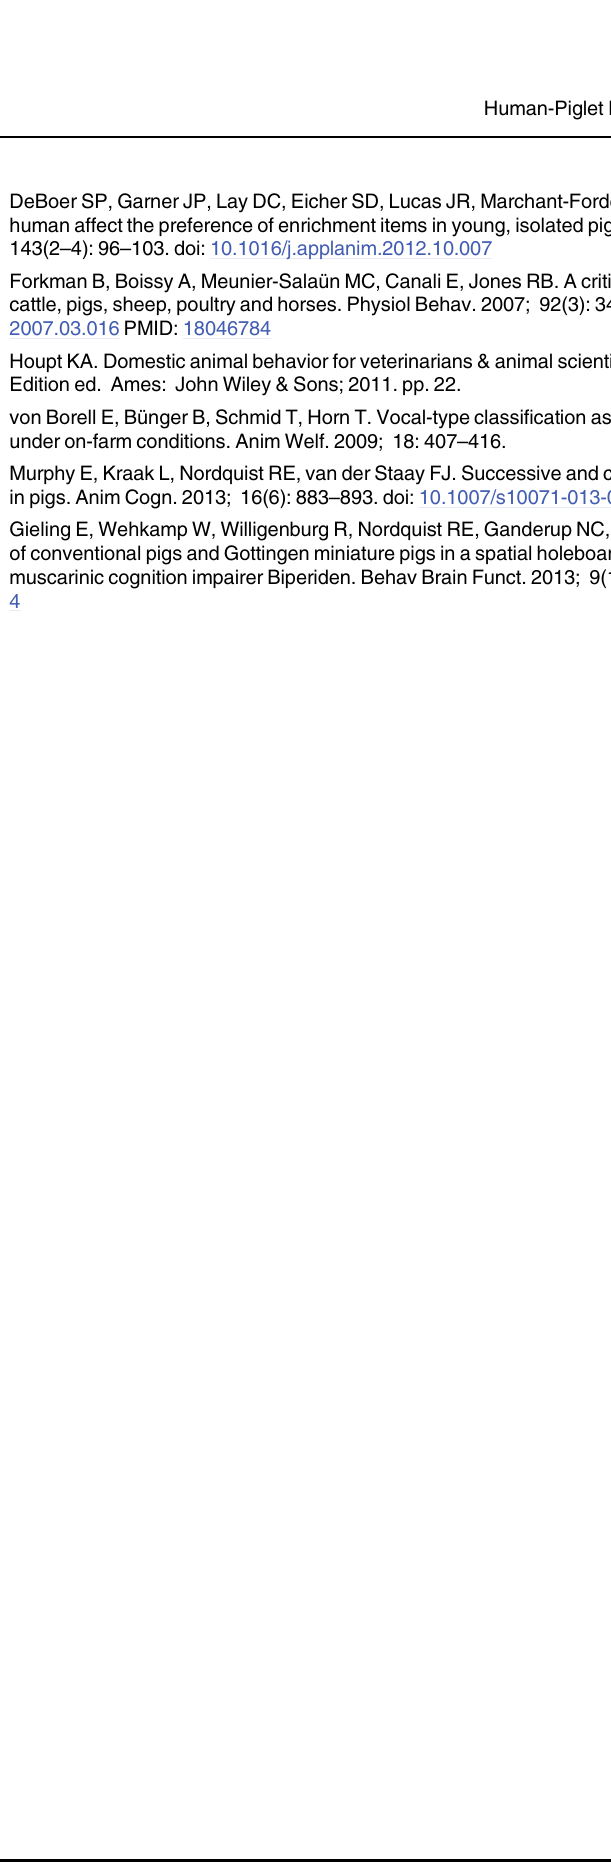
PLOS ONE | DOI:10.1371/journal.pone.0133408 August 5,